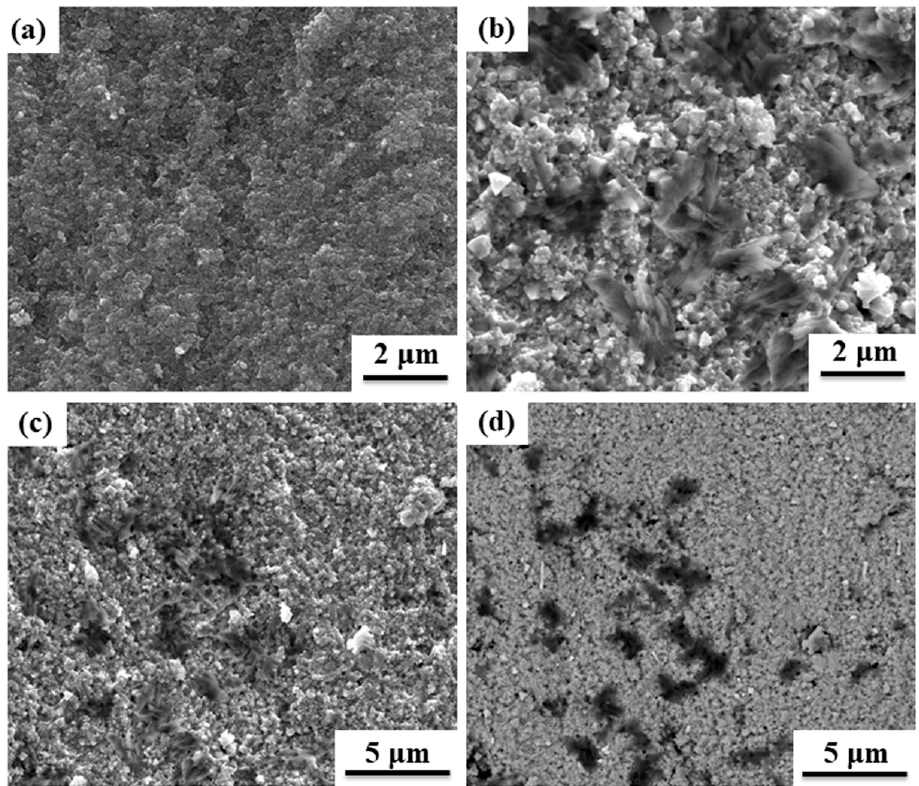
Figure 4. SEM images of the fracture surface of ( a ) pure NiZn ferrite, ( b ) 2 wt.% Ti 3 C 2 T x /NiZn ferrite composites, low magnification SEM images of 2 wt.% Ti 3 C 2 T x /NiZn ferrite composites ( c ) secondary electron image, and ( d ) backscattered electron image (the same area of c ).